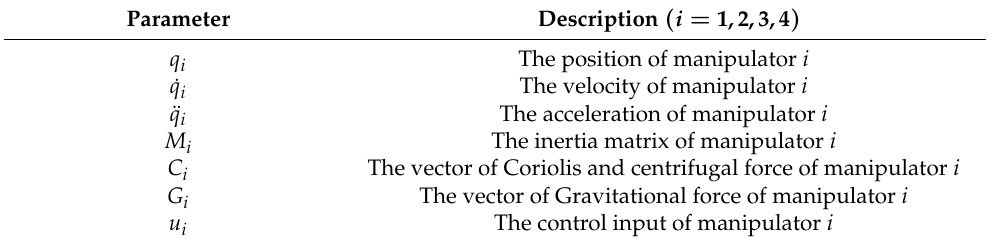
Table 1. The descriptions of the